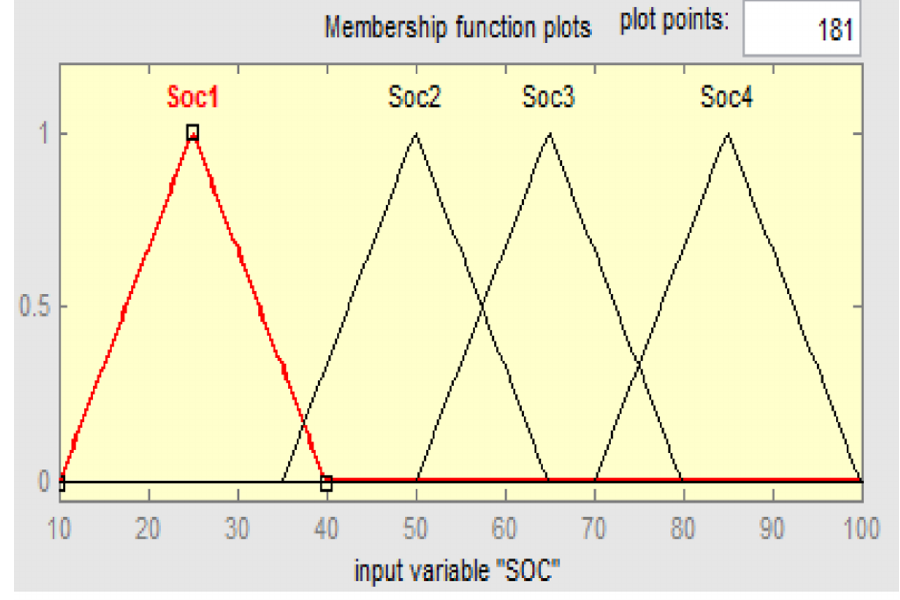
Figure 7. Fuzzified SoC